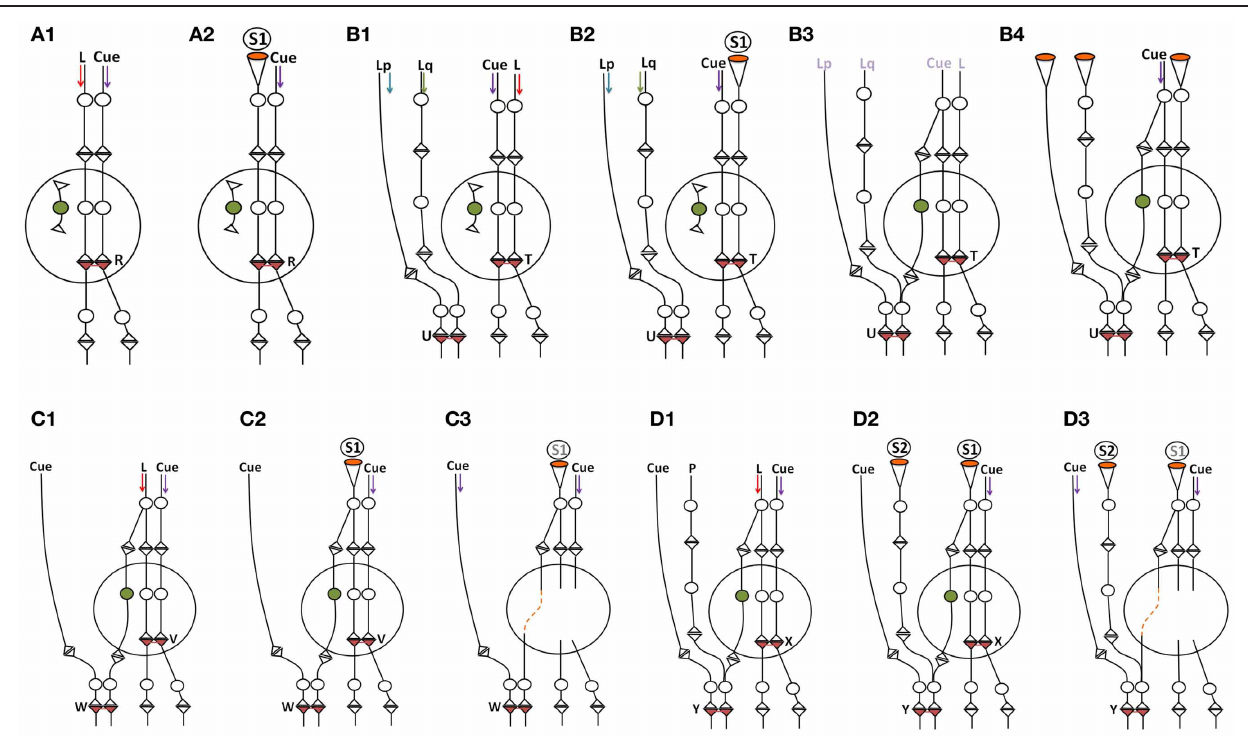
FIGURE 7 | Schematic diagram showing the effect of incorporation of new neurons within the neuronal circuitry. The incorporation of thousands of granule neurons on a daily basis can result in the introduction of new connections between the neurons in the entorhinal cortex and the CA3 neurons. Following learning, the establishment of new neuronal connections can evoke unrelated semblances in response to a specific cue stimulus since the new neuronal connections necessitate the inclusion of the semblances evoked from the unrelated pathways to which it gets connected. This can reduce net memories. However, repetition of the associative learning, related learning, or the simultaneous activation of receptor pairs originally activated during the associative learning can lead to the formation of new inter-postsynaptic membrane hemi-fusions at higher neuronal orders, increasing net semblances for memories. The following are examples of some of the conditions that influence net semblance for memory. Note that the diagrammatic expression of the extrapolation of the semblance (see Figure 2 ) is simplified here. (A1,A2) Learning and memory retrieval in a circuitry before the incorporation of new neuron. (A1) Learning before the incorporation of new neurons in the hippocampal granule layer. L, Item to be learned. An inter-postsynaptic functional LINK is formed at location R when activity from the cue stimulus (one of the associatively learned stimuli) and the item to be learned reach the apposed postsynapses at this location. (A2) Memory retrieval before the incorporation of new neurons in the hippocampal granule layer. Here, a semblance is formed from the re-activation of an inter-postsynaptic functional LINK within the hippocampus. (B1–B4) Reduction in memory due to dilution of semblances following new neuron connections in the circuitry in the absence of repetition of learning or related learning or simultaneous activation of the sensory receptor pair involved in the associative learning. (B1) Associative learning before the addition of a new neuron. Note the presence of an extra-hippocampal inter-postsynaptic functional LINK at location U formed from associative learning between items Lp and Lq. (B2) Memory retrieval by the cue stimulus induces specific semblances at location T immediately following learning (before the incorporation of the new neuron in the circuitry). (B3) A new granule neuron is incorporated into the circuitry in the absence of repetition of learning or related learning or simultaneous activation of the receptor pairs.